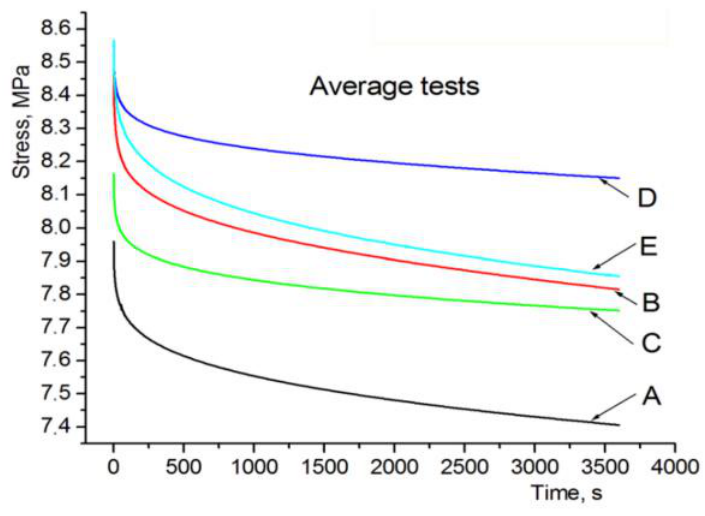
Figure 9. Averaged relaxation curves calculated for specimens